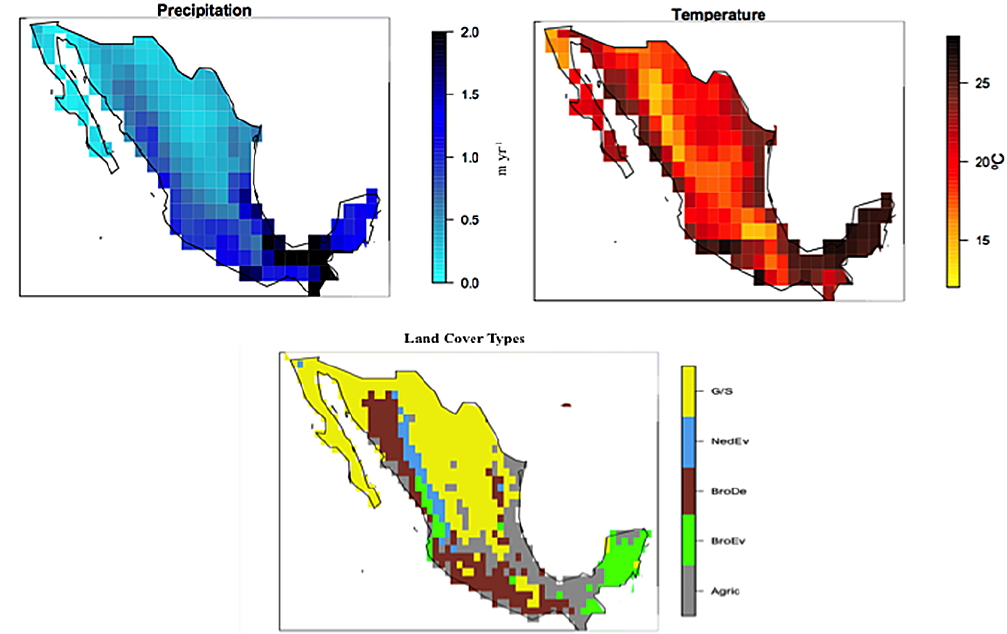
Figure 1. Observed precipitation (myr − 1 ) , temperature ( ◦ C), and land cover types for Mexico (mean of 2000–2005). Agric: croplands; BroEv: broadleaf evergreen forest; BroDe: broadleaf deciduous forest; NedEv: needleleaf evergreen forest; G/S: